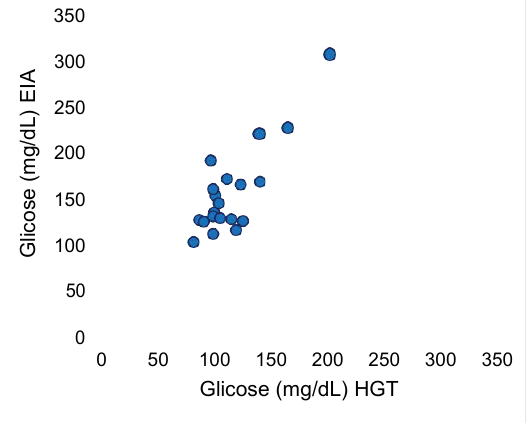
fIGuRE 1 – Graphical analysis of the linear correlation by rank between glucose measurements by hemoglycotest (HGT), artificial intelligence equipment (EIA) Figure 2 shows the graphical representation of the distribution of results from the correlation analysis of glucose measurements by hemoglycotest (HGT) and conventional laboratory measurements, presenting a Spearman correlation coefficient (R²) equal to 0.822 with a strong positive and statistically significant correlation